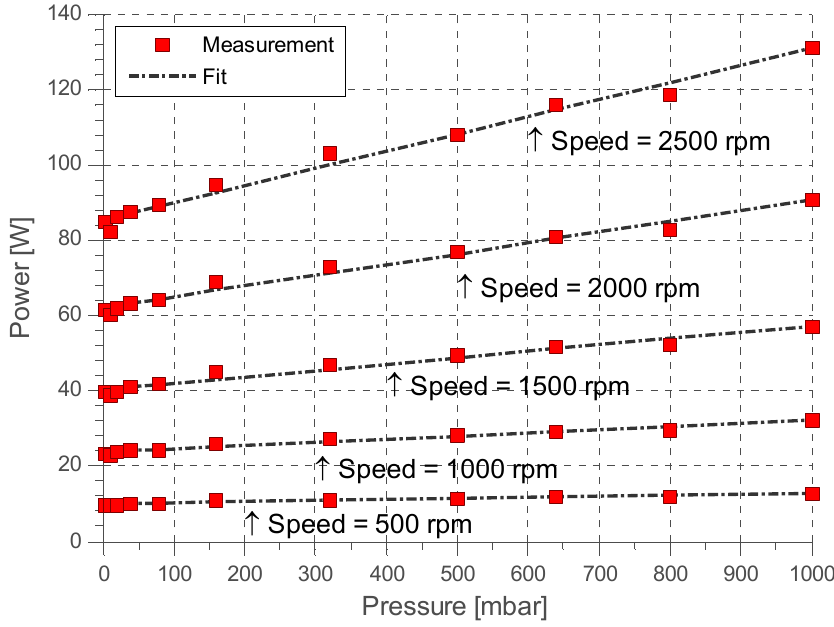
Figure 5. Air friction loss over pressure. Note the linear dependence of power loss on air